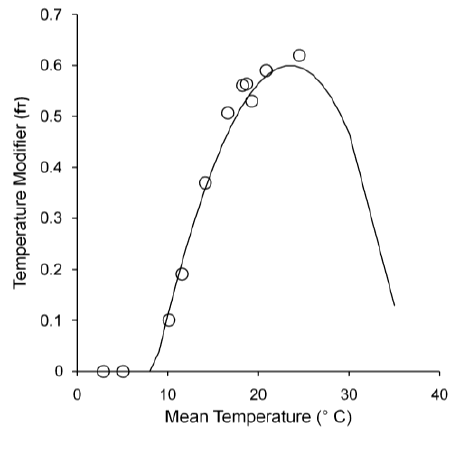
Figure 5. Appearance of the temperature modifier (f determined by fitting 3-PG to data from Takayama. The line observed (solid line) is a fit of the data to the equation of temperature